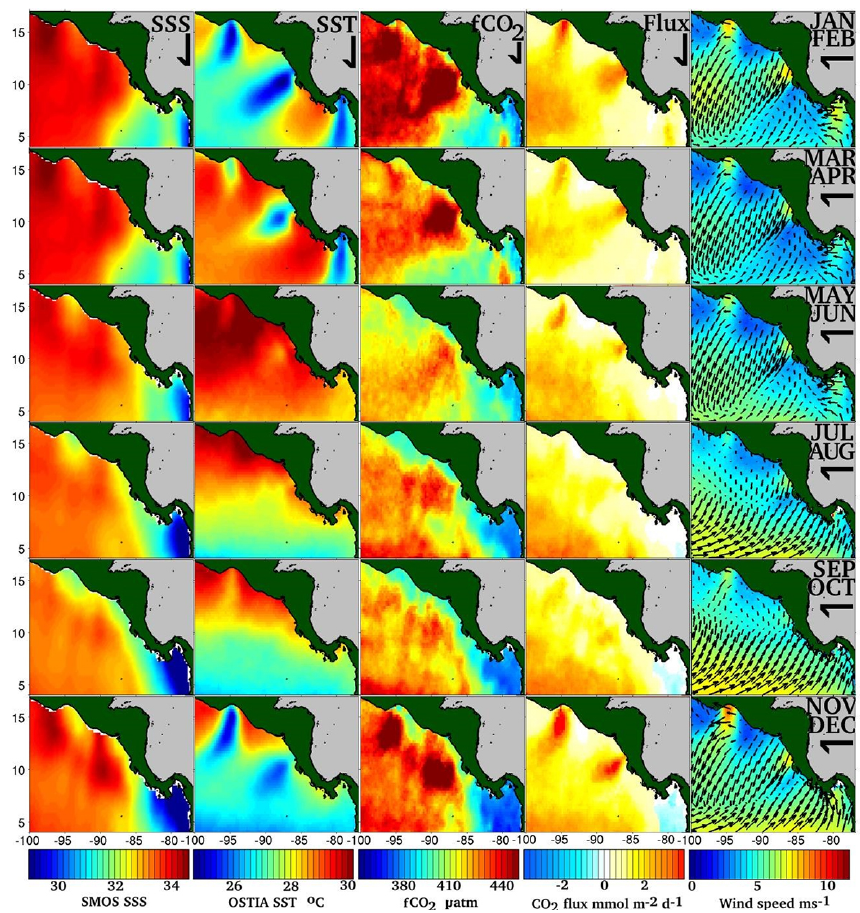
Figure 7. July 2010–June 2014 average SSS, SST, LUT-derived f CO, air–sea fluxes and wind vectors for the ETPO, split bimonthly (January + February, March + April, May + June, July + August, September + October, November +